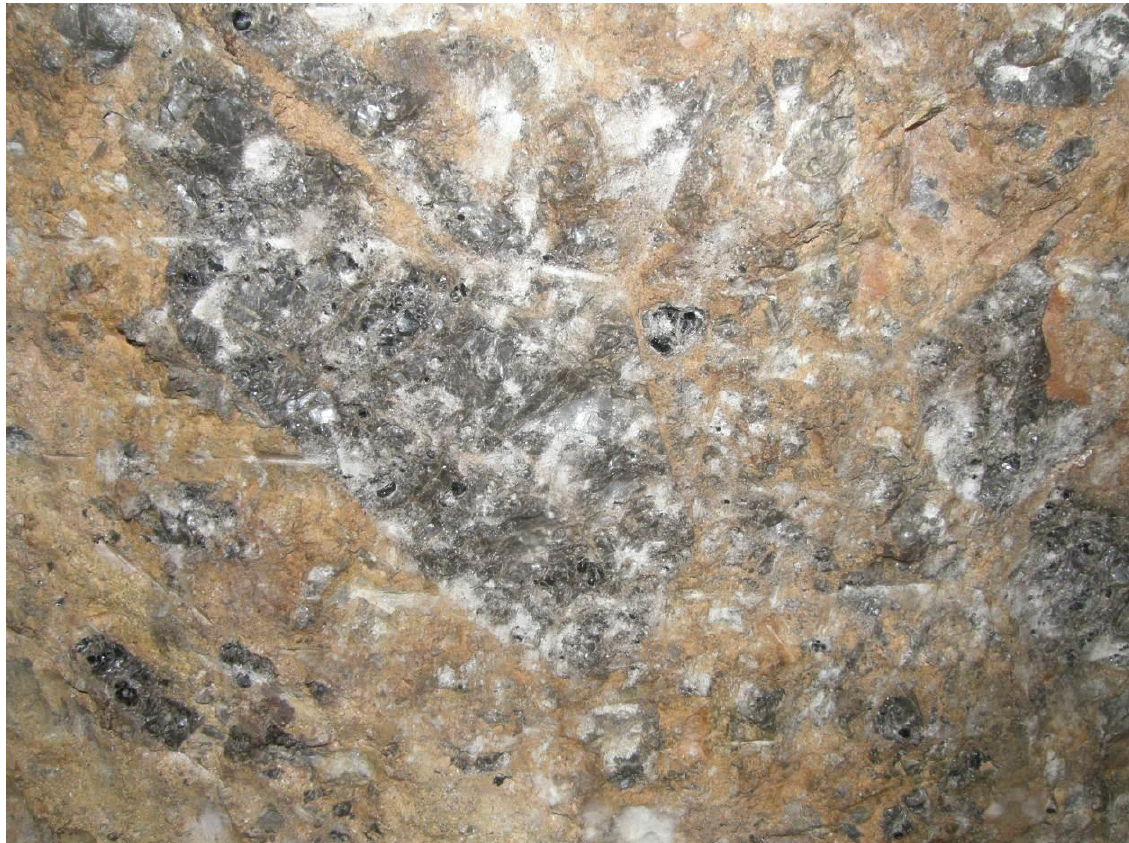
Figure 9. New wine cellar at Vinicky with 10-15 cm large obsidian lumps (black) in rhyolitic (beige) and perlitic lava (grey). (Photo courtesy of P.